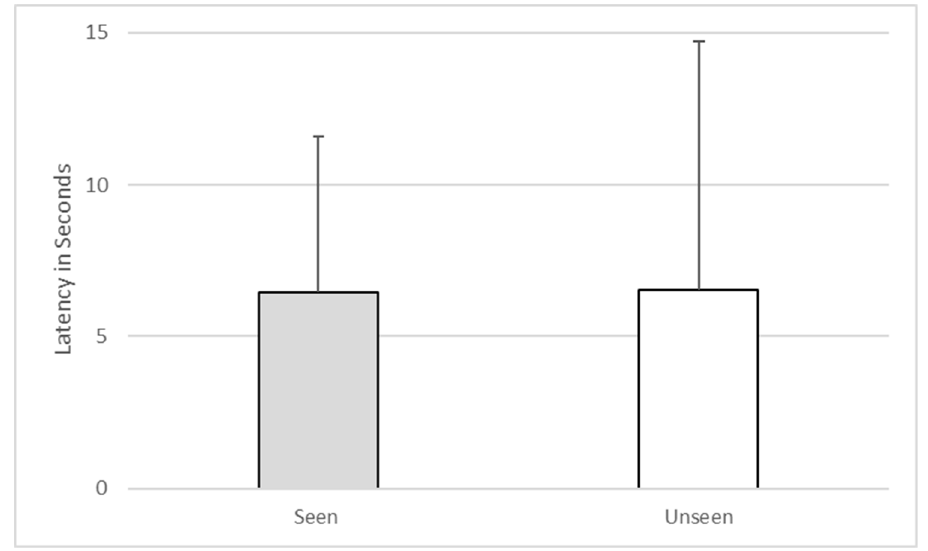
Figure 4. Latency to make a choice on seen versus unseen trials during Experiment 1.